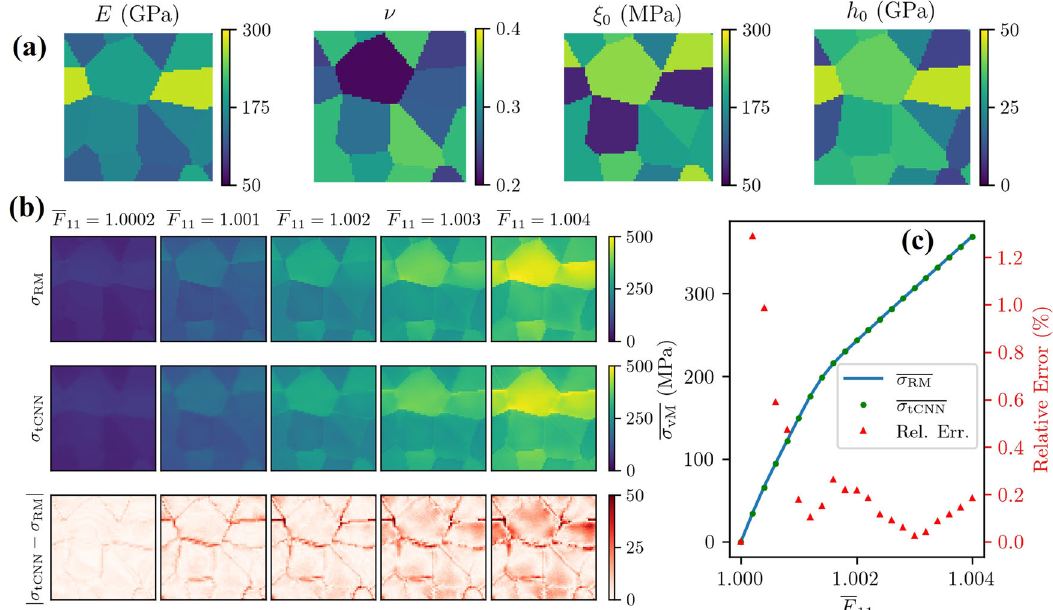
Fig. 2 Ten-grain test microstructure subject to uniaxial extension along the horizontal axis. a Young ’ s modulus E , Poisson ’ s ratio ν , initial fl ow resistance ξ 0 , linear isotropic hardening modulus h 0 . b Results for F 11 . c σ RM (blue curve), σ tCNN (green points), and relative error (red triangles) given by 100 ð σ tCNN (cid:3) σ RM Þ = σ RM versus F 11